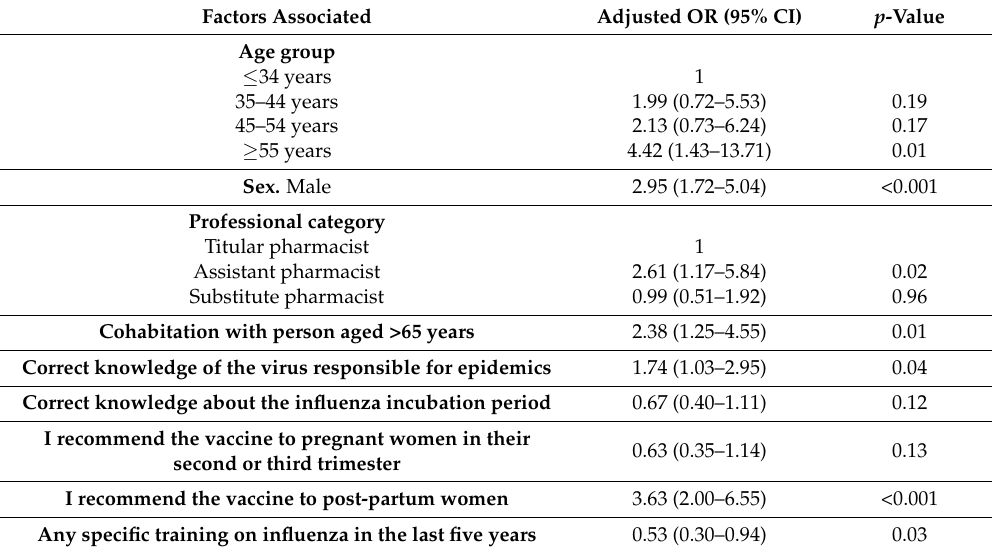
Table 3. Influenza vaccination coverage in community pharmacists in the 2013–2014 season according to knowledge of and recommendations about influenza and influenza vaccination.